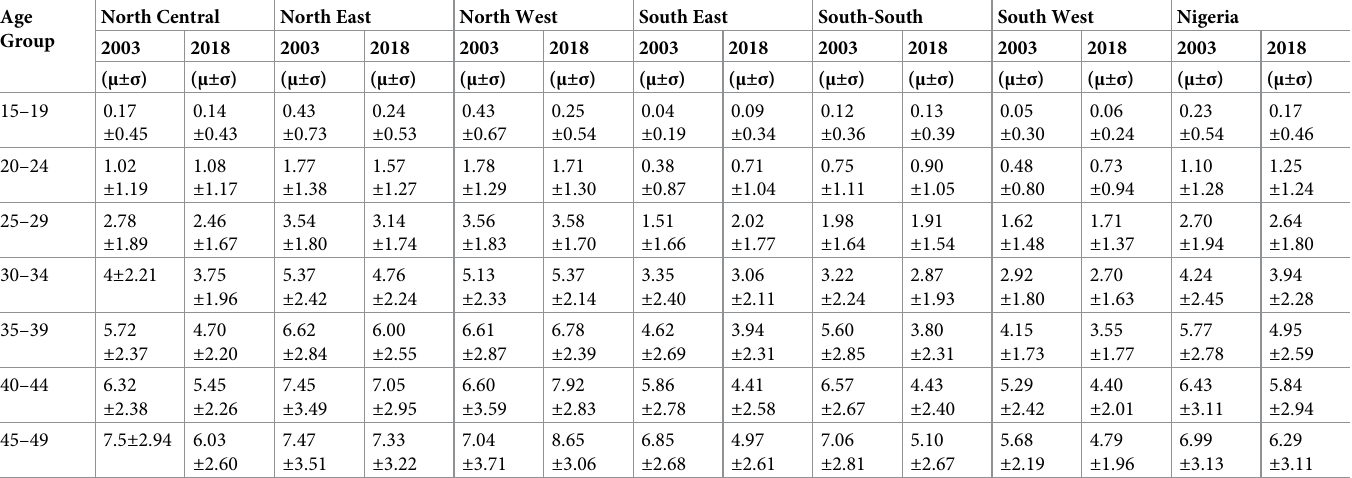
Table 1. Mean number of children ever born by the age of